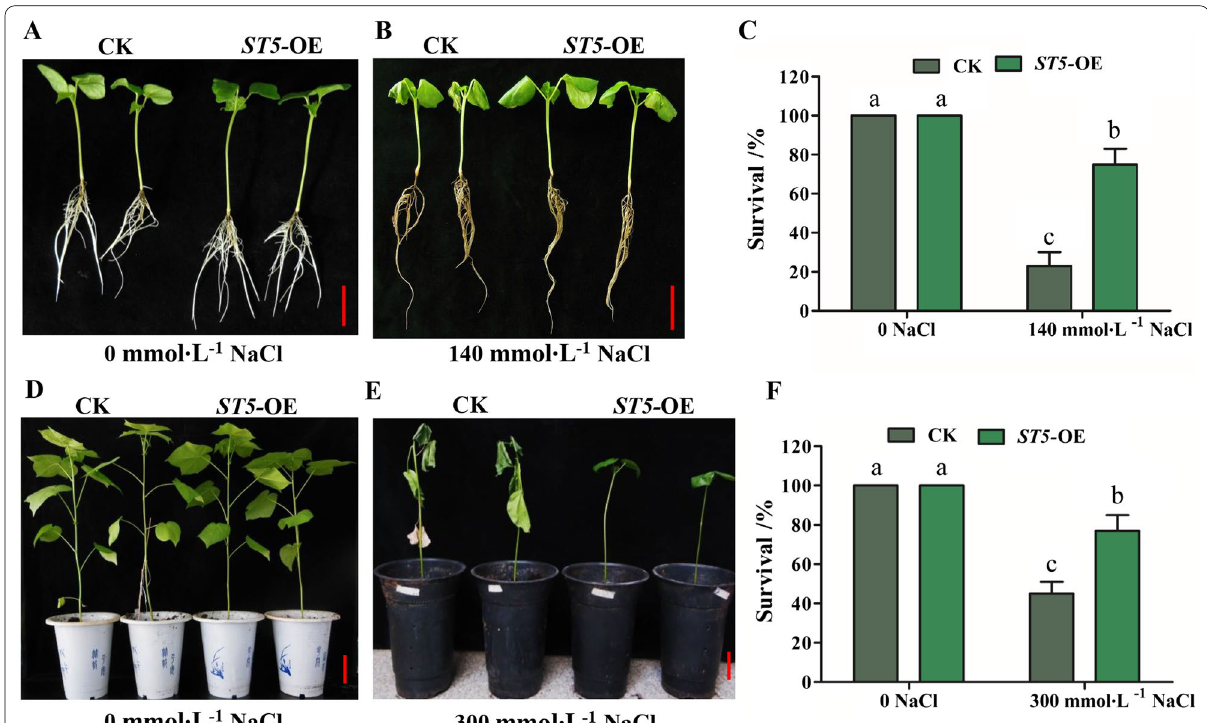
L − 1 NaCl for 3 days · SD of ± 4 cm. F Survival rate of transgenic seedlings =